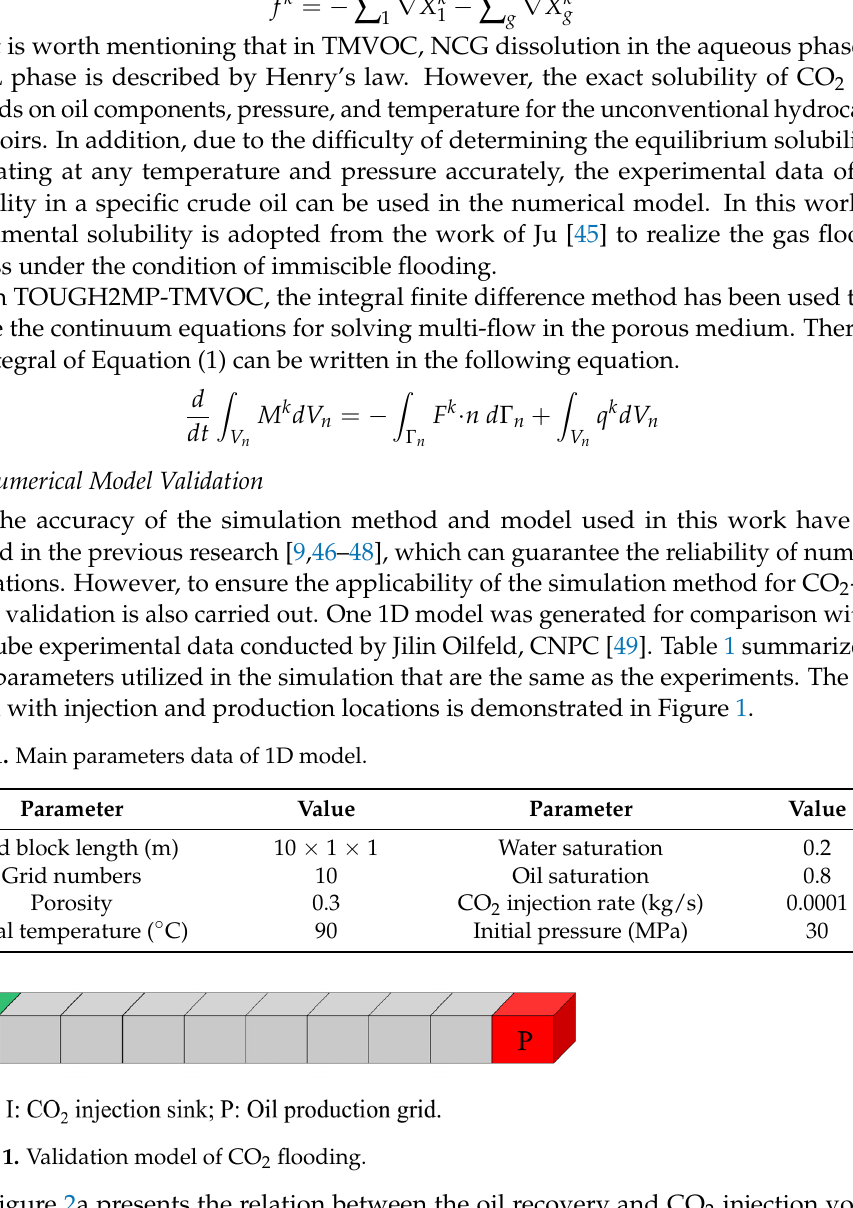
Figure 2. The ( a ) comparison of simulation results with experimental data, ( b ) comparison of recov- ery under different grid numbers. The study of discretization and grid convergence is performed to demonstrate the numerical method for the CO 2 -EOR. In this section, six different grid block sizes (a differ- ent number of cells) are generated, with 5, 10, 20, 40, 80, and 160 cells, respectively. All the parameters for the six simulations are the same as those of the model used for the com- parison with experimental data above. It can be observed that the recovery degree grad- ually improves with the increase in the number of cells (Figure 2b). The maximum final recovery value is 96.68% with 160 cells, which is close to the recovery of 96.31% obtained with 80 cells. Similarly, the results obtained by 40 cells, 20 cells, and 10 cells are 95.56%, 94.62%, and 93.68%, respectively. It is worth mentioning that the value of recovery does not deviate from each other significantly in the five cases. However, the final oil recovery is maintained at 89.04% when the total cells are only 5; thus, increasing the grid block size